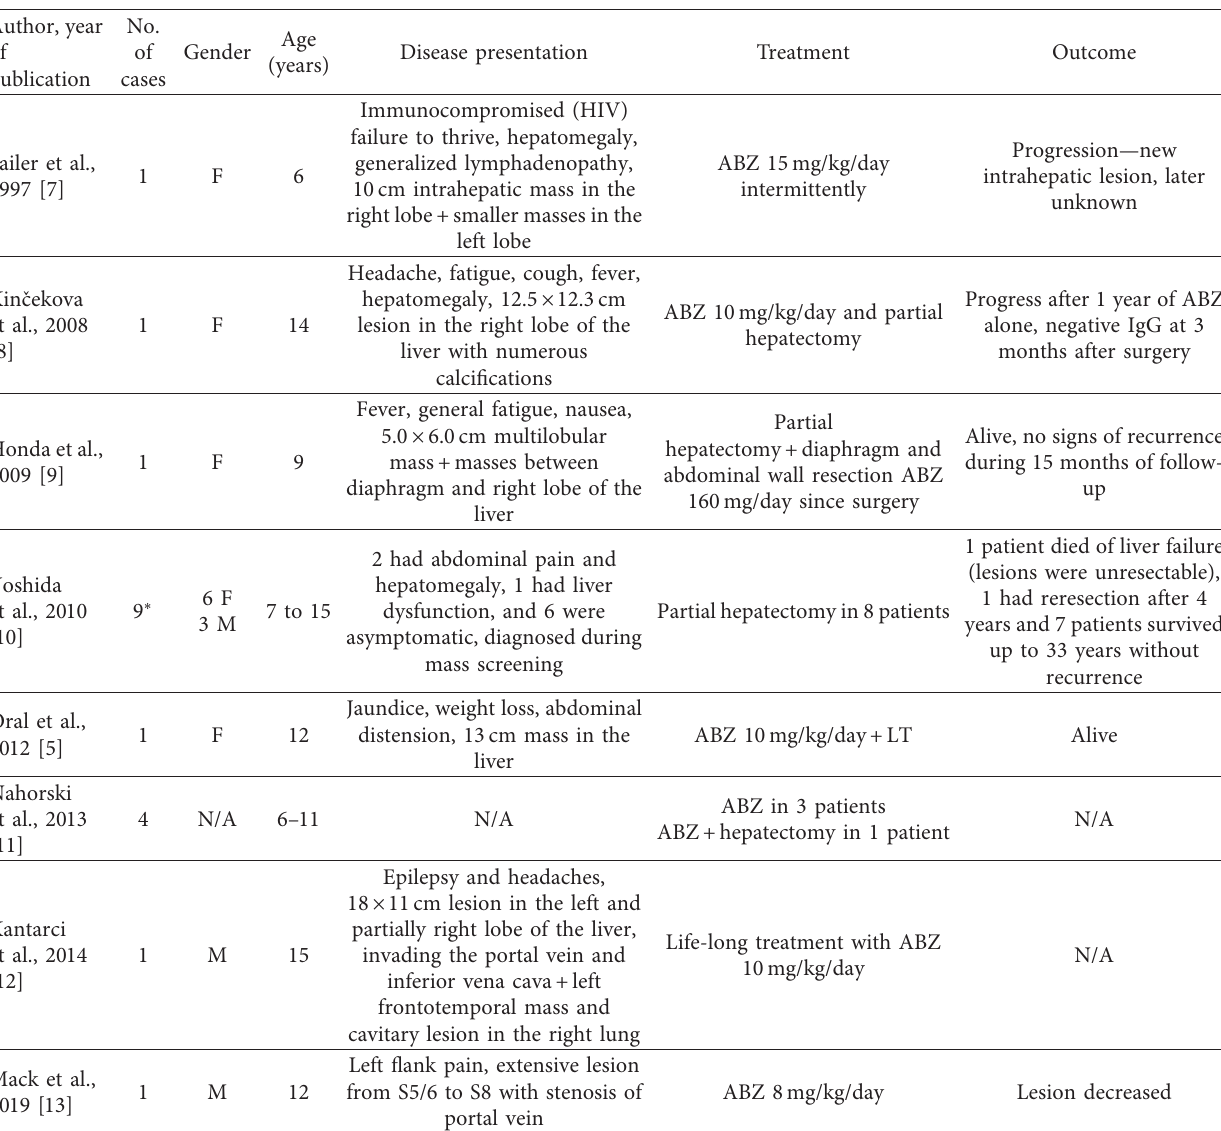
Table 1: Previously published cases of AE in